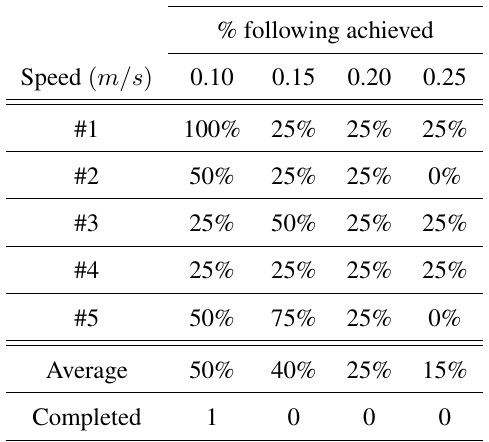
Table 1. Following experiments. (Left) Sonar Ring. (Right)